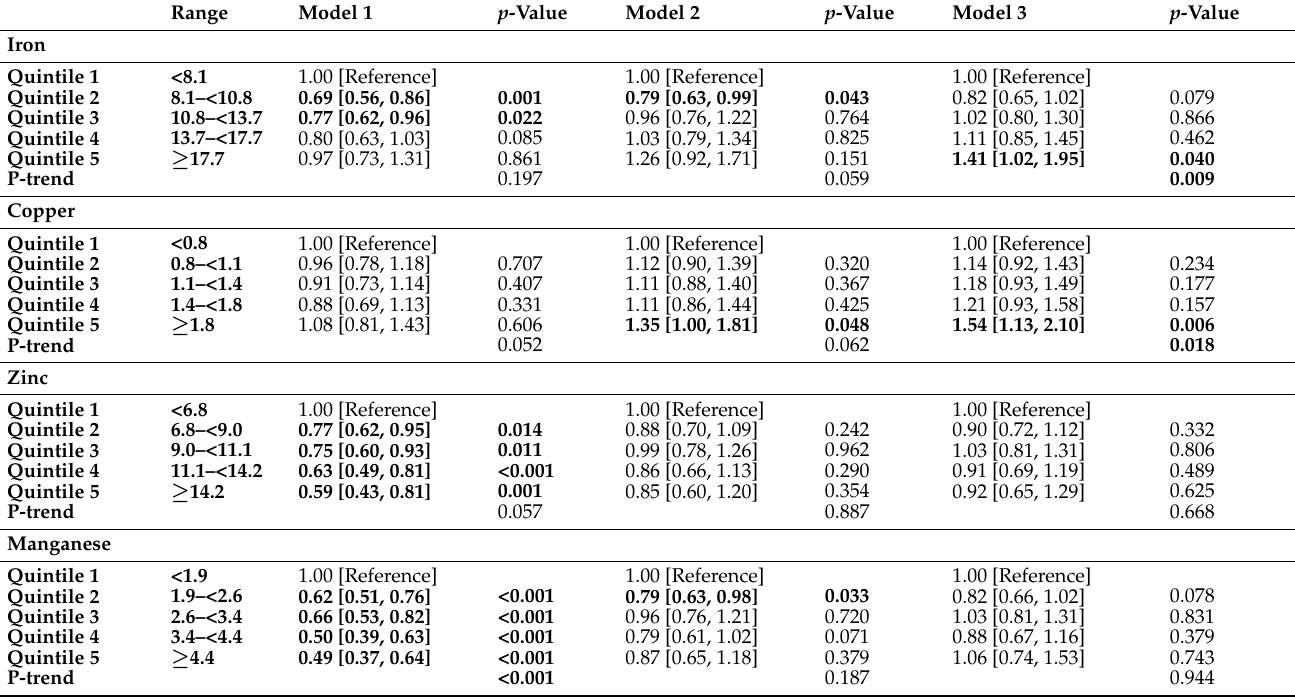
Table 3. Odds ratio and 95% confidence intervals of cognitive impairment according to dietary intake levels of iron, copper, zinc, and